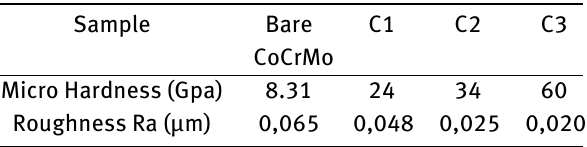
Table 4: Micro hardness and Surface Roughness Results of the Samples Sample Bare C1 C2 C3 CoCrMo Micro Hardness (Gpa) 8.31 24 34 60 Roughness Ra ( µ m) 0,065 0,048 0,025